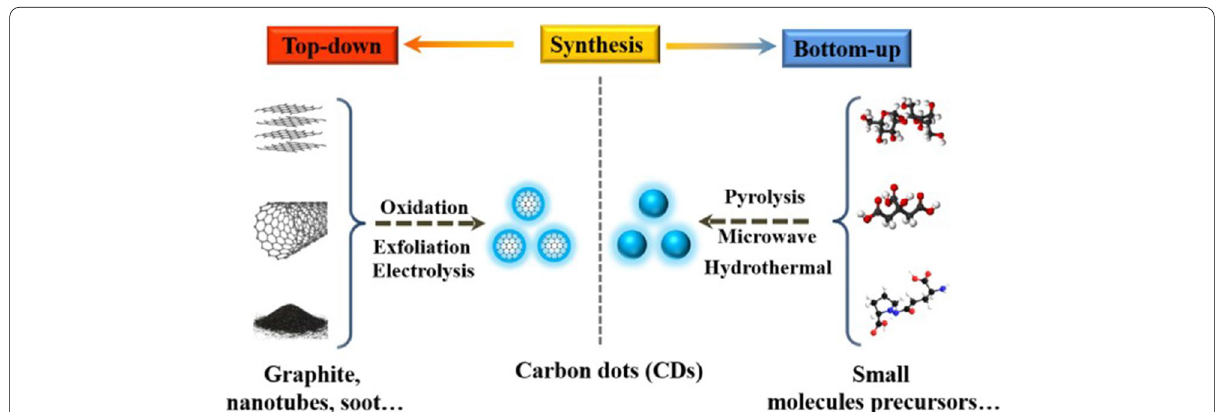
Fig. 4 A schematic representation of general synthetic approaches of carbon quantum dots [112]. Reproduced with permission. Copyright © 2022 Wiley ‐ VCH GmbH